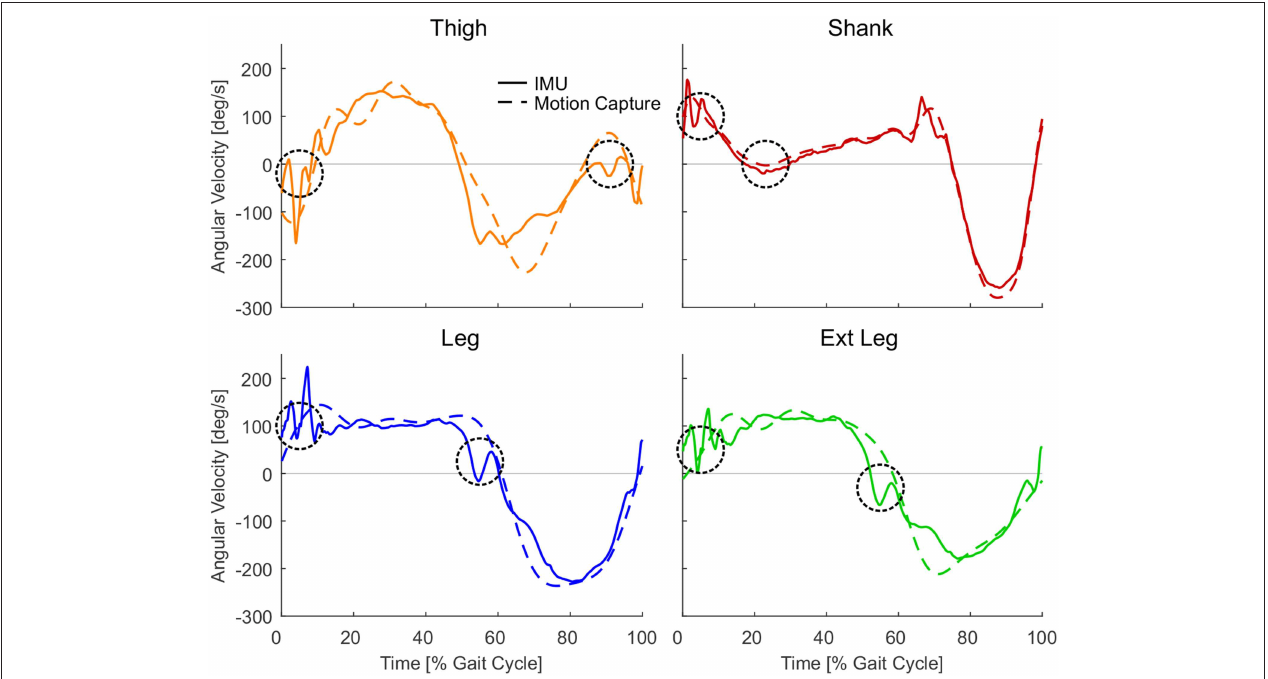
FIGURE 7 | Single subject angular velocities for one stride from the inertial measurement units (solid) and the motion capture (dashed) for the thigh (orange, descent − 10 ◦ at 1.7m/s), shank (red, ascent 10 ◦ at 0.9m/s), leg (blue, descent − 10 ◦ at 1.7m/s), and extended leg (green, descent − 10 ◦ at 1.7m/s) segment. Circles indicate phases where the IMU data can have unwanted sign changes in the angular velocity due to oscillations or by the nature of the segment movement. Representative strides were selected from one subject and condition with the greatest number of zero crossings shown in Figure 6